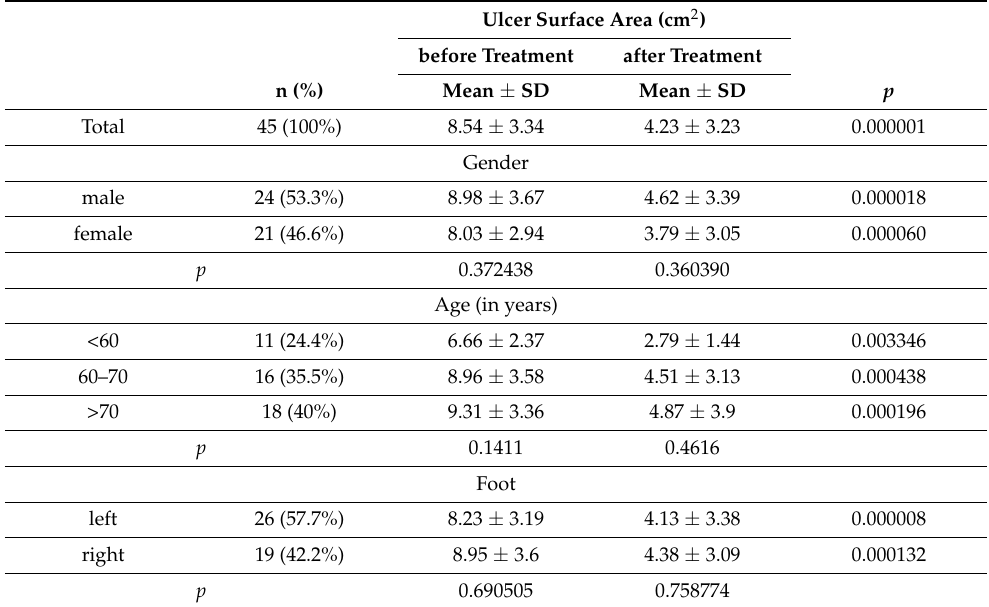
Table 1. The ulcer surface area (mean ± standard deviation SD) assessed with the planimetric method, before and after the end of local hyperbaric oxygen procedures, for the whole group of patients and by gender, age, and ulcer